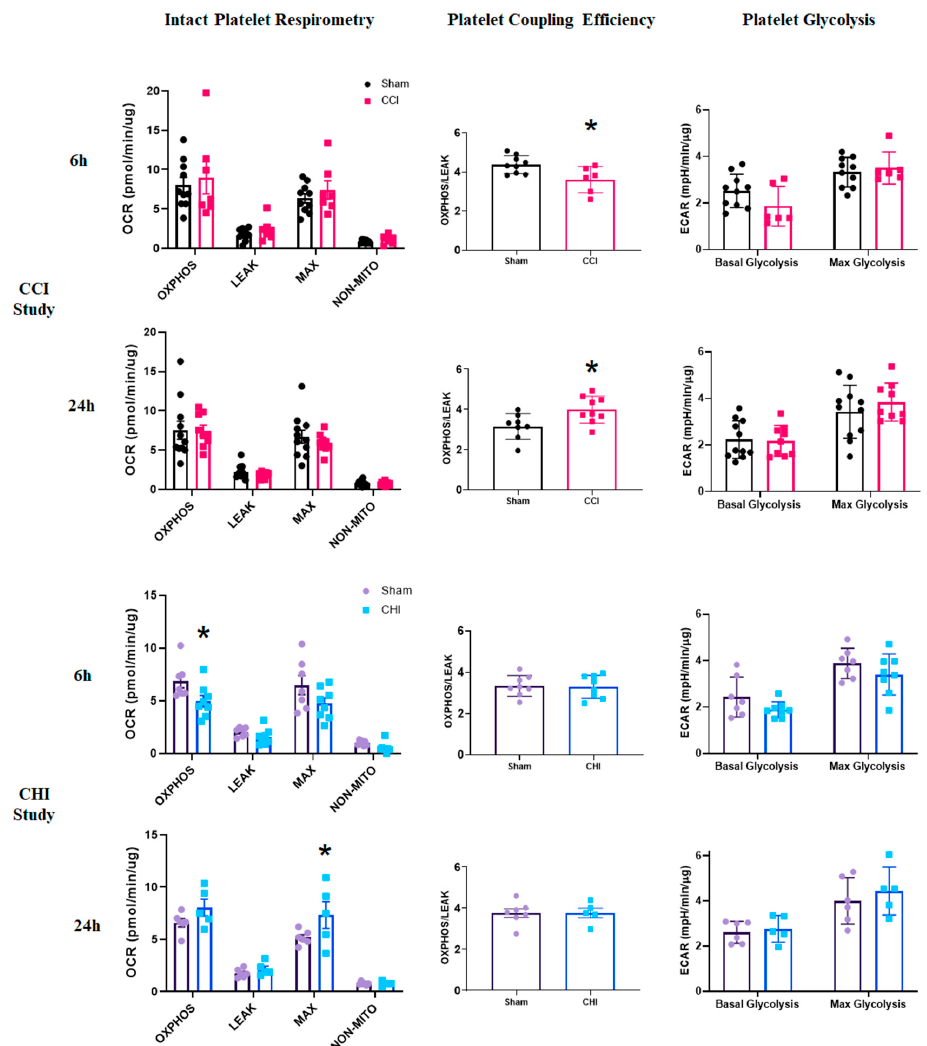
Figure 4. Differential alterations in platelet coupling and oxidative phosphorylation acutely following contusion brain injury and mild closed head injury. (Top Panels) Mice received either sham injury or severe CCI followed by euthanasia at either 6 or 24 h post-injury. Isolated platelets underwent respirometry using the Seahorse XFe96. At 6 or 24 h post-CCI, there were no significant differences in any state of respiration measured. Platelet coupling efficiency was reduced 6 h after CCI compared to sham. t = 2.656; * p = 0.012. There was a significant increase in platelet coupling efficiency 24 h after CCI compared to sham. t = 2.637; * p = 0.019. Platelet glycolysis was unchanged at 6 and 24 h after CCI. n = 6–10/group, (Bottom Panels) Mice received either sham injury or mild CHI followed by euthanasia at either 6 or 24 h post-injury. Isolated platelets underwent respirometry using the Seahorse XFe96. At 6 h post-CHI, OXPHOS CI+CII was significantly lower in the CHI group compared to sham. t = 2.284; * p = 0.040. In general, overall platelet respiration was lower at 6 h after CHI compared to sham. At 24 h, post-CHI, MAX CI+CII was significantly higher in the CHI group compared to sham. t = 3.12; * p = 0.0142. In general, overall platelet respiration was higher at 24 h after CHI compared to sham. Platelet coupling efficiency was unchanged at 6 and 24 h after CHI. There was no significant difference in platelet glycolysis at either 6 or 24 h following CHI. n = 5–8/group. Mean ±